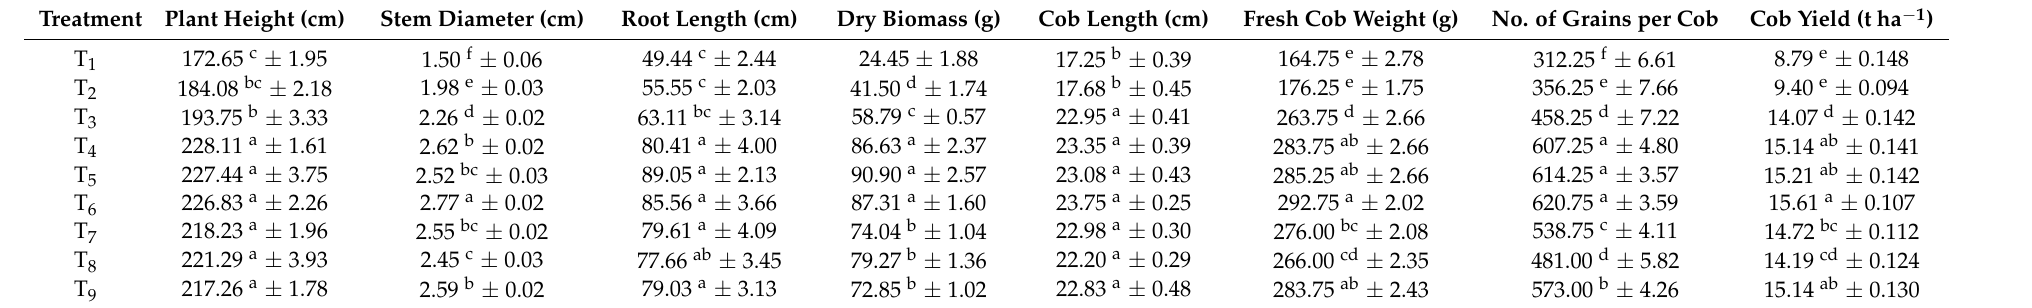
Table 3. Effect of treatments on maize plant growth